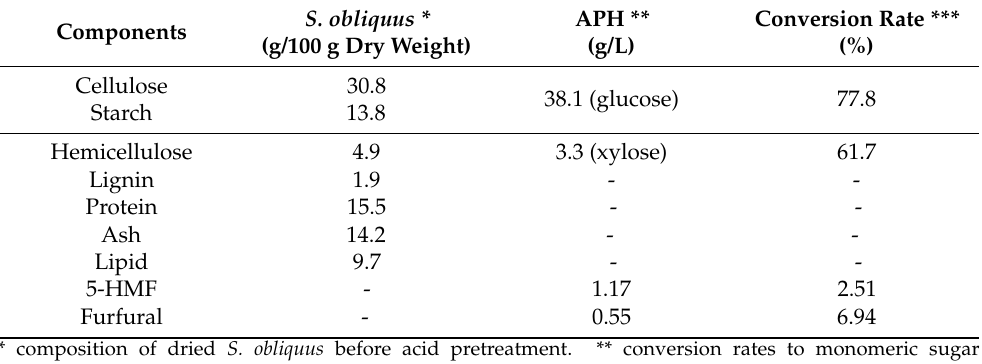
Table 1. The contents of the main components of S. obliquus and the concentrations of monomers in APH.